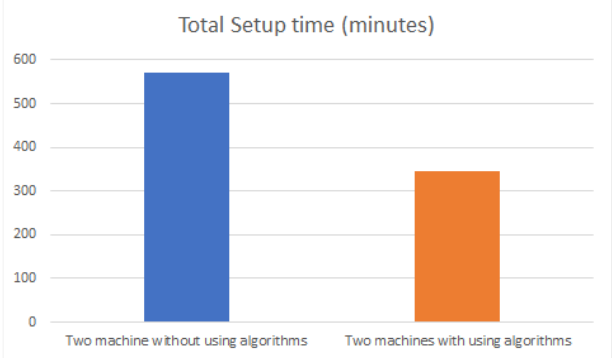
Figure 8. The overall performance of the number of schedules for two machines.